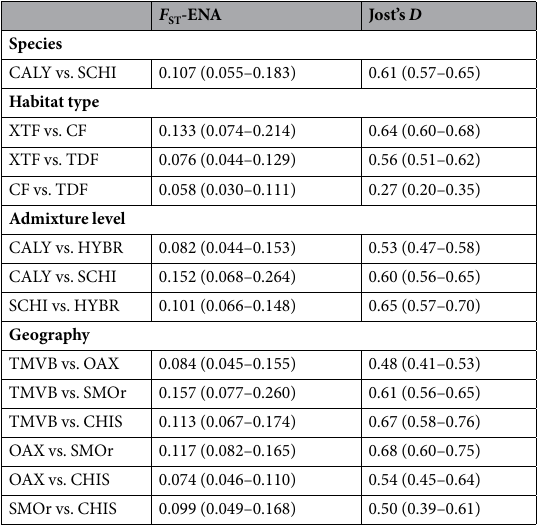
Table 1. Genetic differentiation ( F ST ) corrected by the presence of null alleles and absolute allele frequencies differences (Jost’s D ) between groups with 95% CI. TMVB = calyculatus group, SMOr = schiedeanus group, OAX = Oaxaca region, CHIS = Chiapas region. CF = cloud forest, XTF = temperate forest and xeric groups, TDF = Tropical dry forest. HYBR = admixed populations from Oaxaca and Chiapas regions. Estimates were done over 9